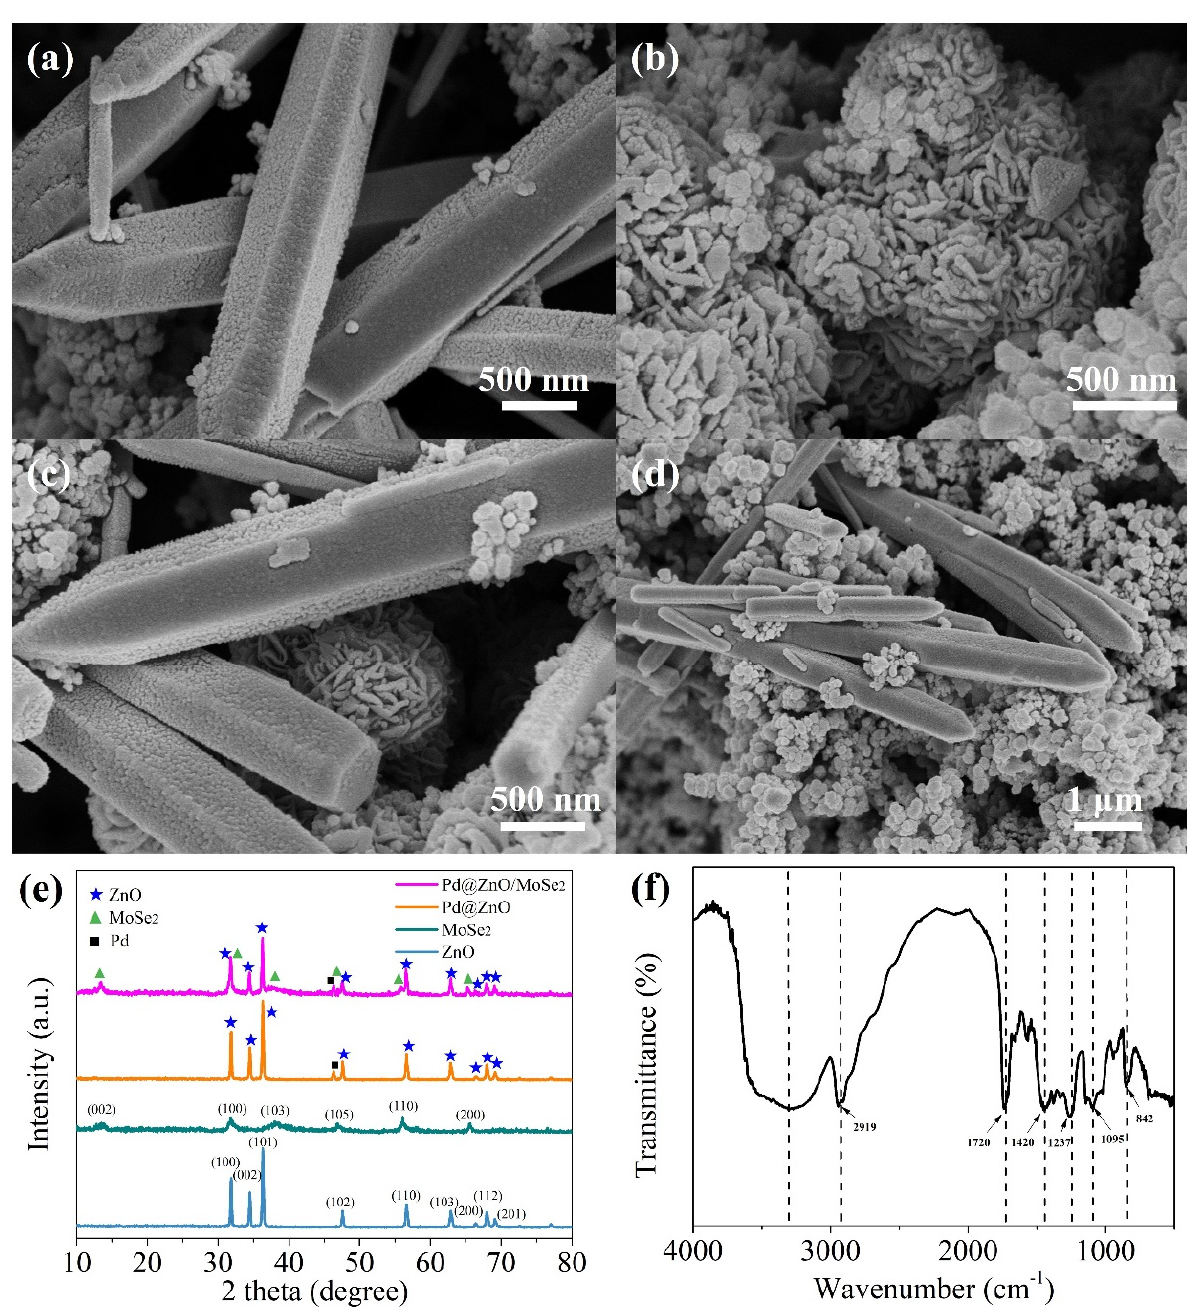
Figure 4. SEM images of ( a ) pure ZnO nanofibers, ( b ) pure MoSe 2 nanoflowers and ( c , d ) Pd@ZnO/MoSe 2 . ( e ) FTIR spectrum of PVA samples. ( f ) XRD of ZnO, MoSe 2 , Pd@ZnO and Pd@ZnO/MoSe 2